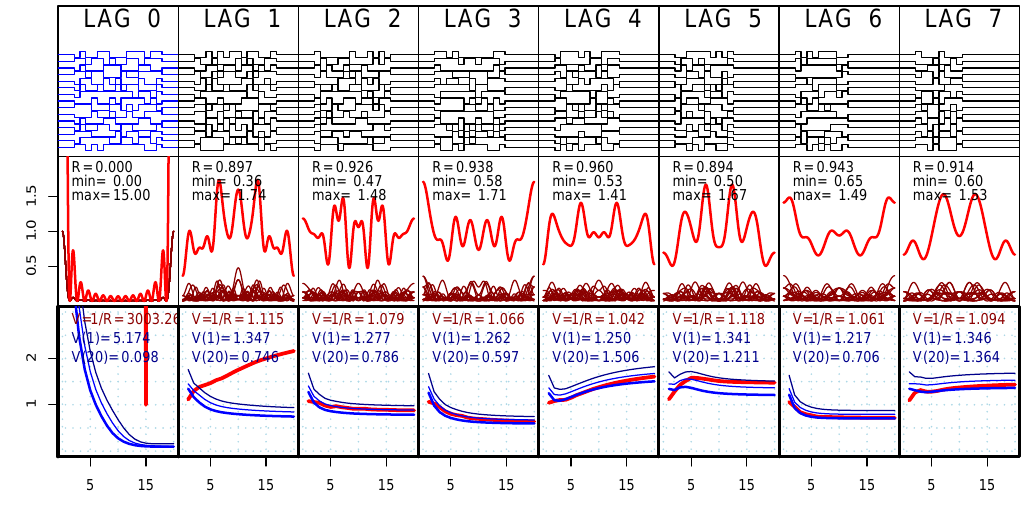
Fig. 9. A set of 15 randomly chosen pulses of 15 bauds each. It seems to be roughly equally good as the chosen set of 4 pulses in Fig.